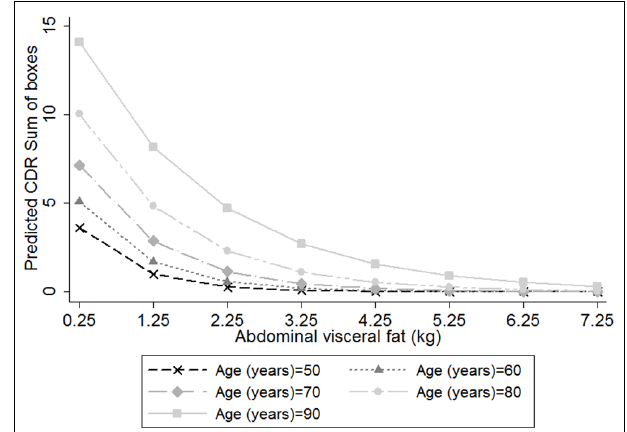
FIGURE 2 | Predicted clinical dementia rating (CDR)-sum of boxes (CDR-SB) scores, according to the amount of abdominal visceral fat in individuals with different ages, considering the inclusion of an interaction term between visceral fat and age on the association between visceral fat and CDR-SB. We used negative binomial regression adjusted for height, age, sex, education, diabetes mellitus, hypertension, stroke, current smoking status, current alcohol use and physical inactivity. Age = 50 years old (cross marker); Age = 60 years old (triangle marker); Age = 70 years old (diamond marker); Age = 80 years old (circle marker); and Age = 90 years old (square